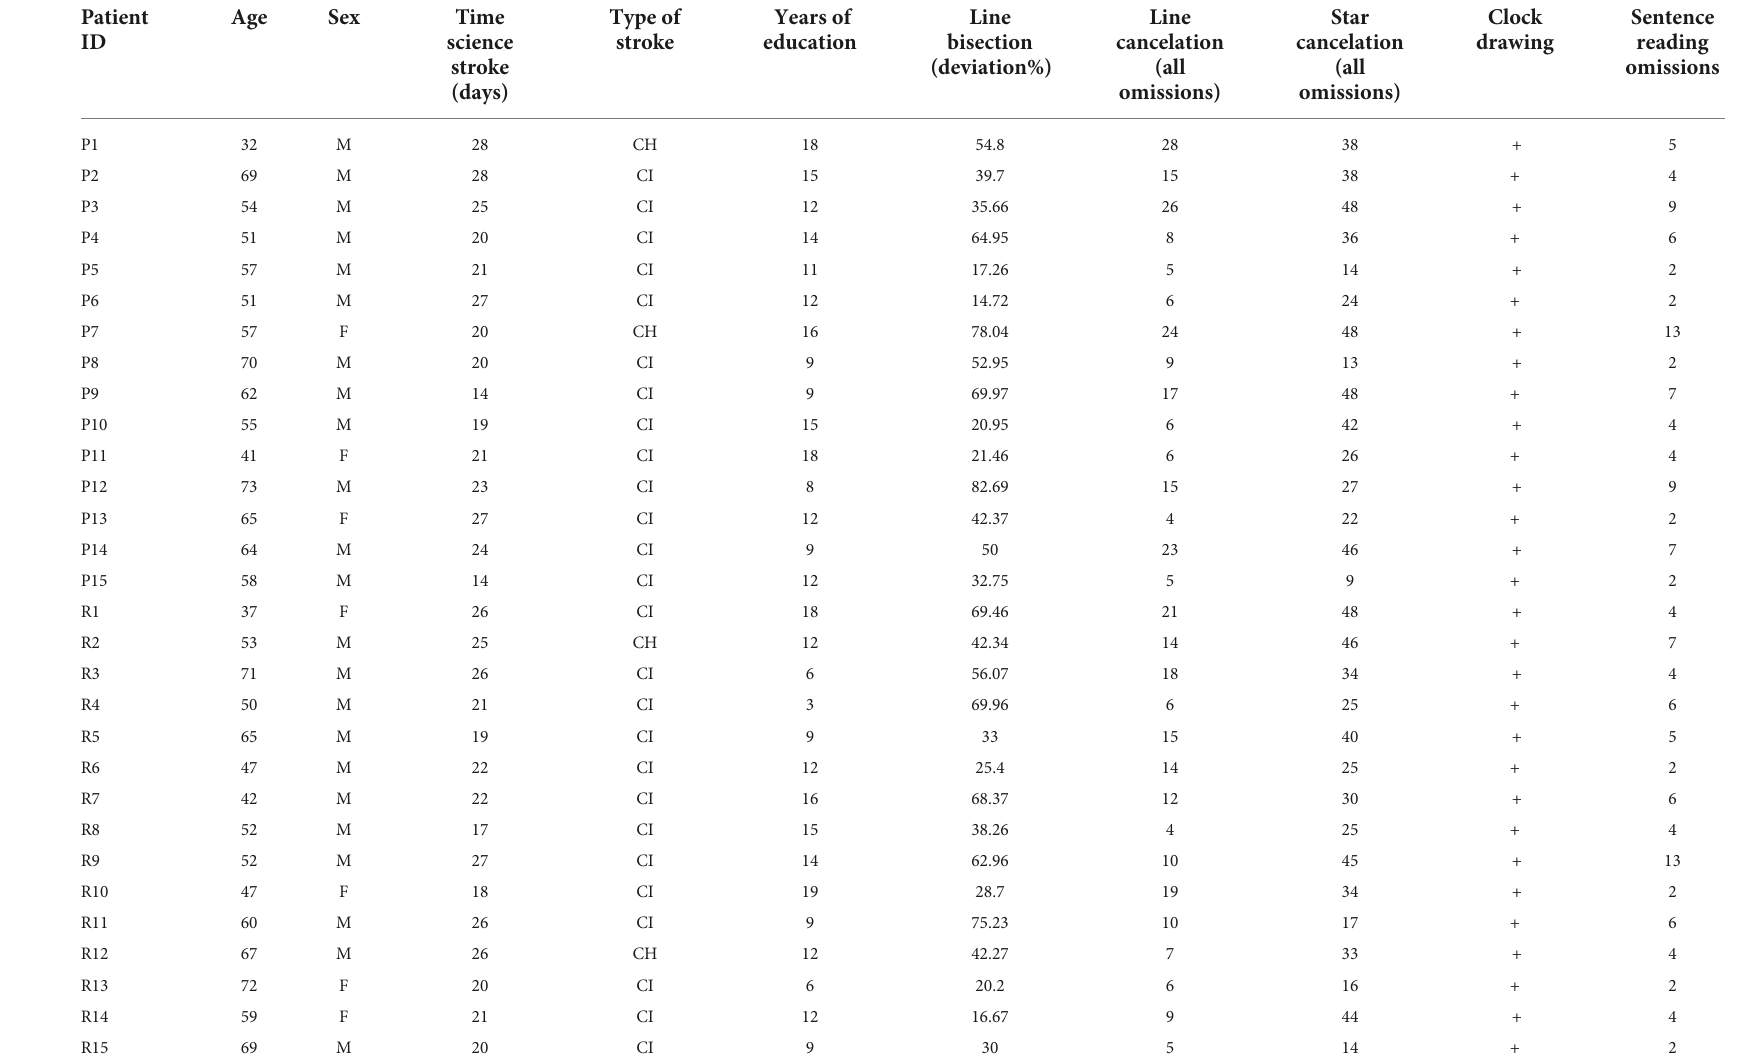
TABLE 1 Demographic data and clinical